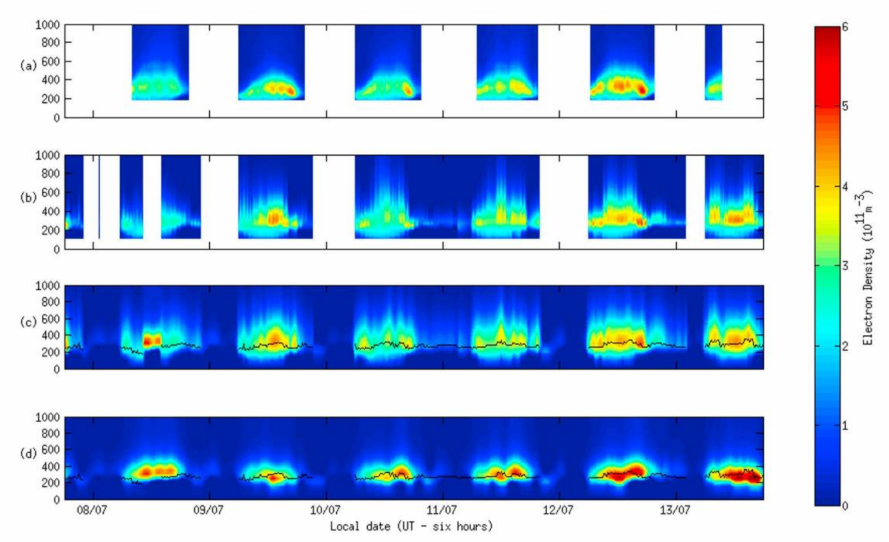
Figure 9. ( a ) Jicamarca incoherent scatter observations, which should be considered the ground truth in this experiment, ( b ) Jicamarca ionosonde observations, ( c ) a reconstructed image that includes the ionosonde observations, and ( d ) a reconstructed image that does not have the ionosonde observations (from [54]). The black line in the images shows the ionosonde peak